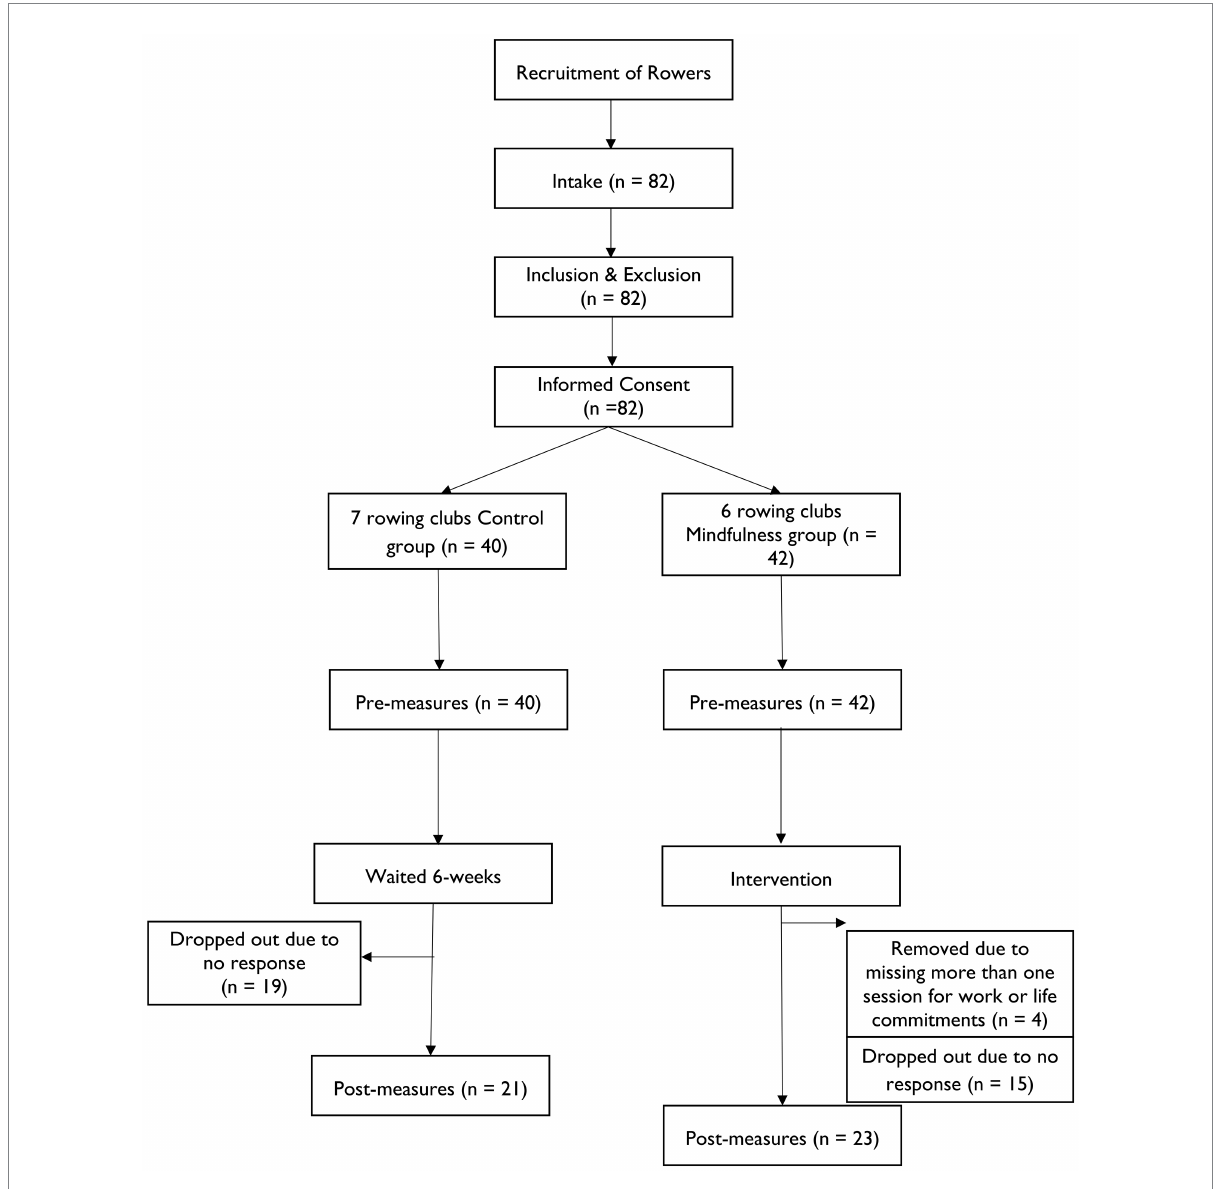
FIGURE 1 Participant recruitment and study